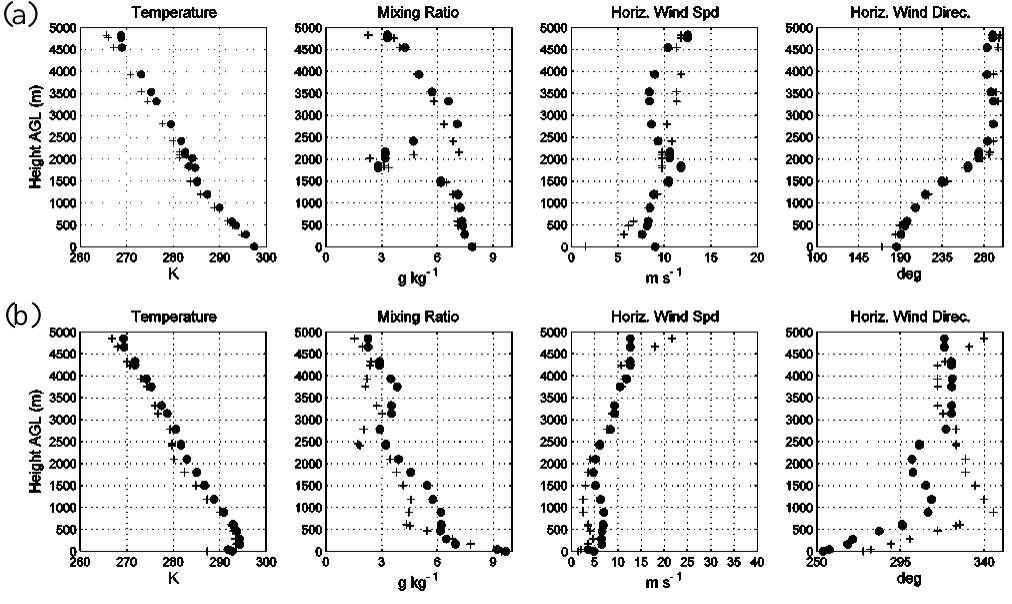
Fig. 4. Model verification versus height using radiosonde measurements of temperature, water vapor mixing ratio, scalar average horizontal wind speed and horizontal wind direction in the lowest 5km at KDTX (42 ◦ 42 0 N83 ◦ 28 0 W) 00Z 4 July 2007 (a) and 12Z 7 July 2007 (b) . Model estimates are interpolated to observations and both are organized into 10m bins. Each column shows the (bin-averaged) observed values (+) and model estimates